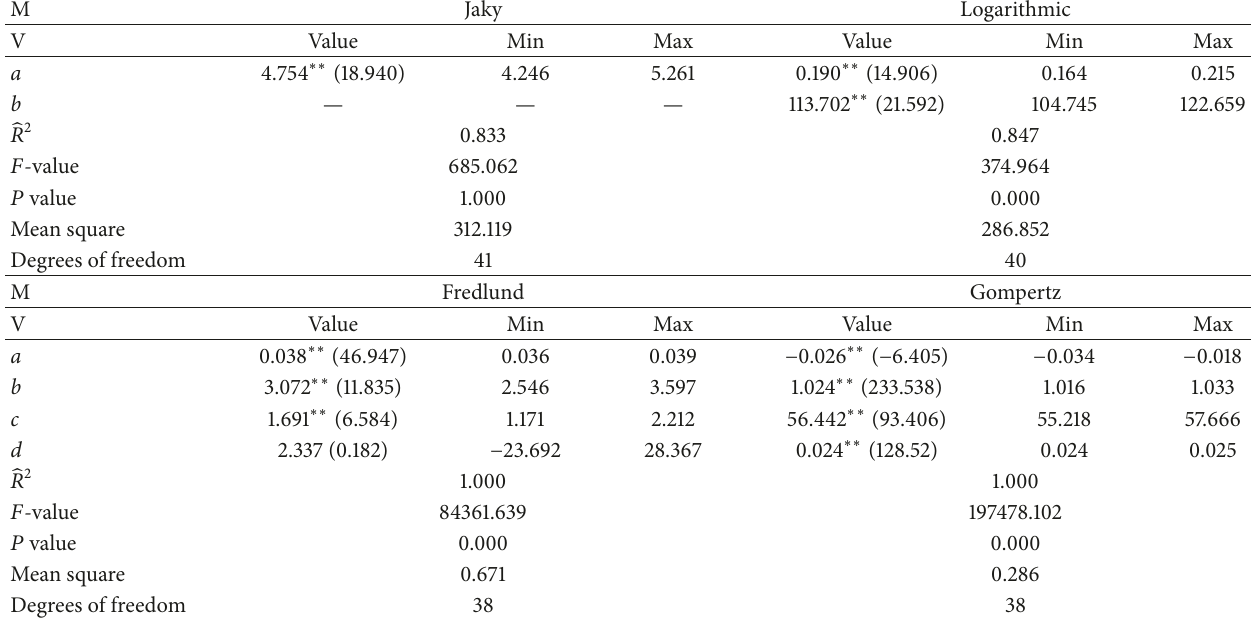
Table 4: Fitting parameters of L-3 by laser diffraction